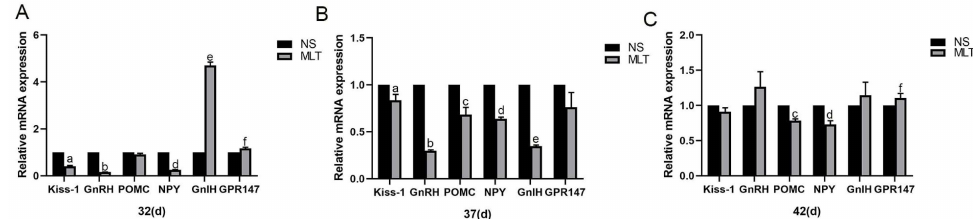
Figure 5. Melatonin’s effects on the expression of reproductive-related neuronal mRNA in the female mice’s hypothalamus (n = 13). ( A ) At 32 days old. ( B ) At 37 days old. ( C ) At 42 days old. a, b, c, d, e, f: p < 0.05 vs. the NS group; 32 d, 32 days; 37 d, 37 days; 42 d, 42 days; NS, normal saline; MLT,